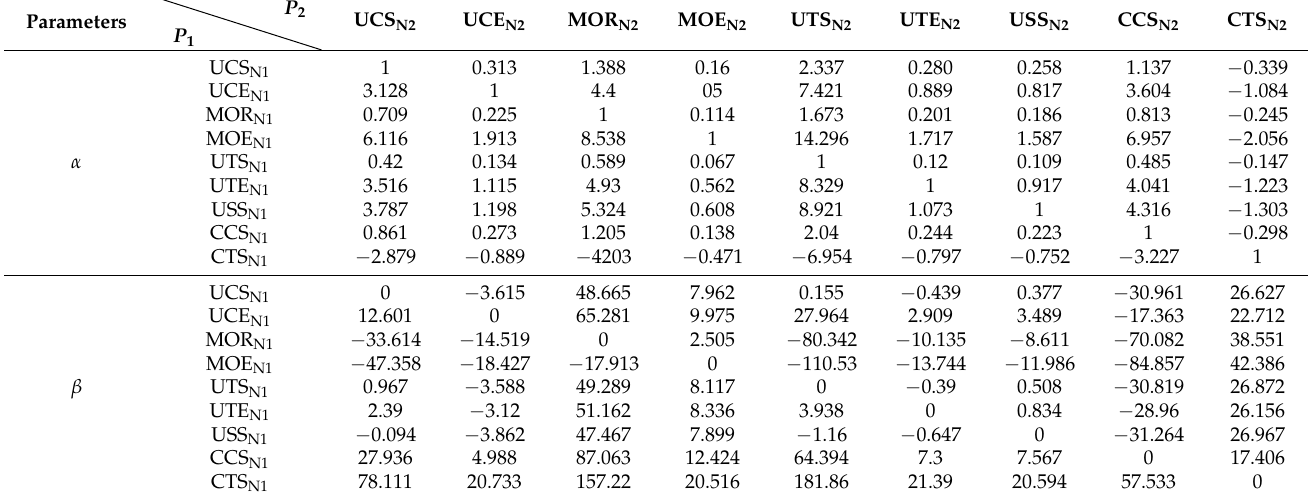
Table 5. Mechanical property conversion parameters of node specimens.